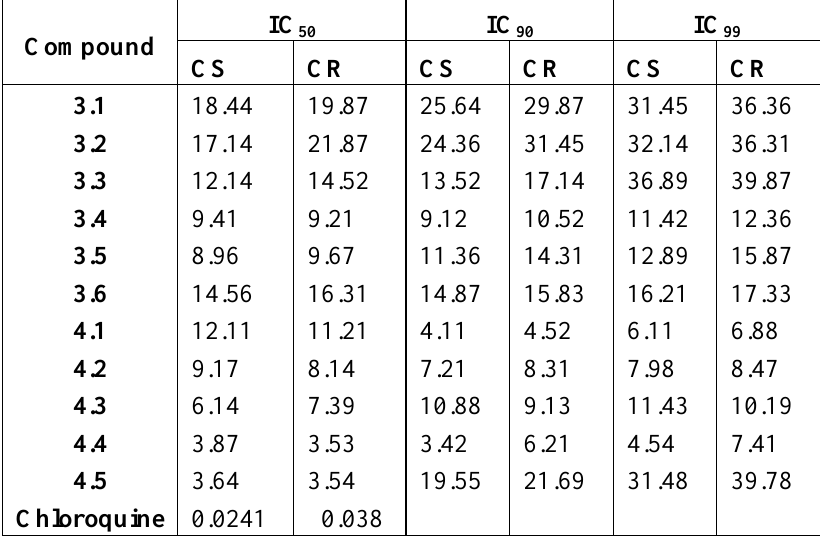
Table 1. Antimalarial activity of compounds by schizont maturation assay against chloroquine sensitive (CS) and chloroquine resistant (CR) strains of P. falciparum